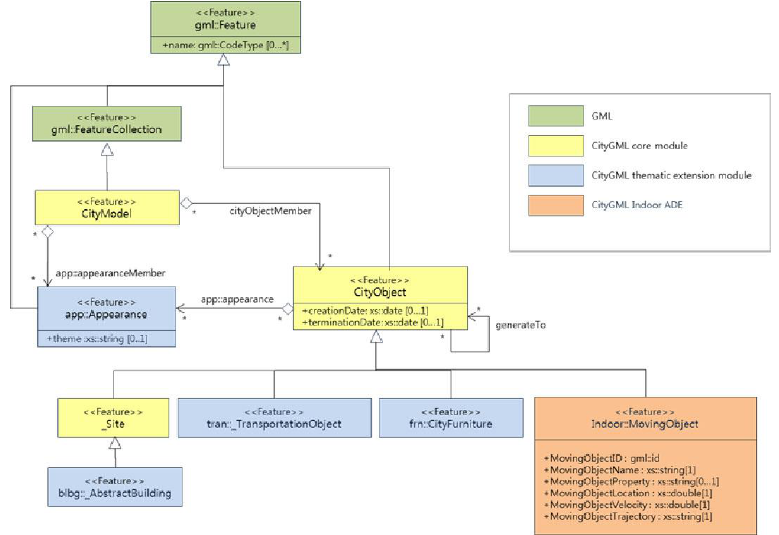
Figure 5. Core Indoor model of